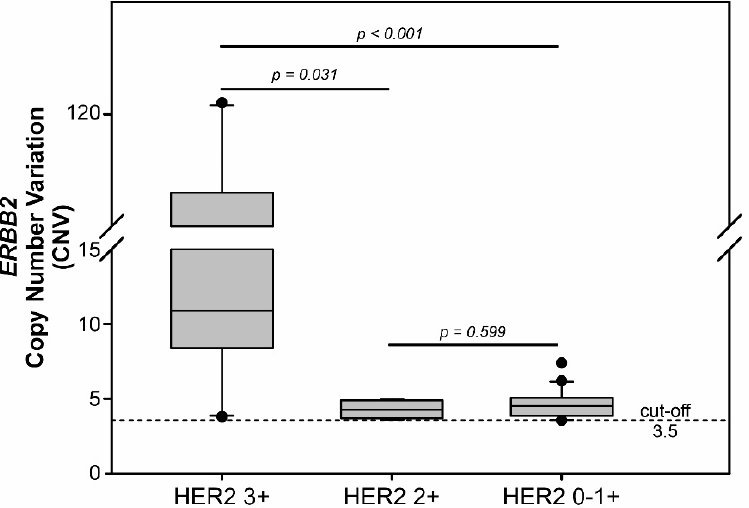
Figure 1. The box plot shows the ERBB2 CNV positive value distribution in the FFPE-DNA of HER2 3+, HER2 2+, and HER2 0–1+ GEA subgroups (retrospective cohort). Statistically significant differences were present between HER2 3+ and HER2 2+ or HER2 0–1+ subgroups. No difference was found when comparing HER2 2+ and HER2 0–1+ patients. The p values were calculated using a two-tailed Wilcoxon Mann-Whitney test; a p -value < 0.05 was considered statistically significant. CNV, copy number variation.